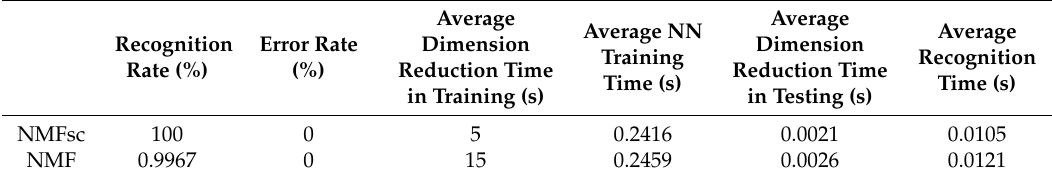
Table 3. Experimental comparison of NMFsc and